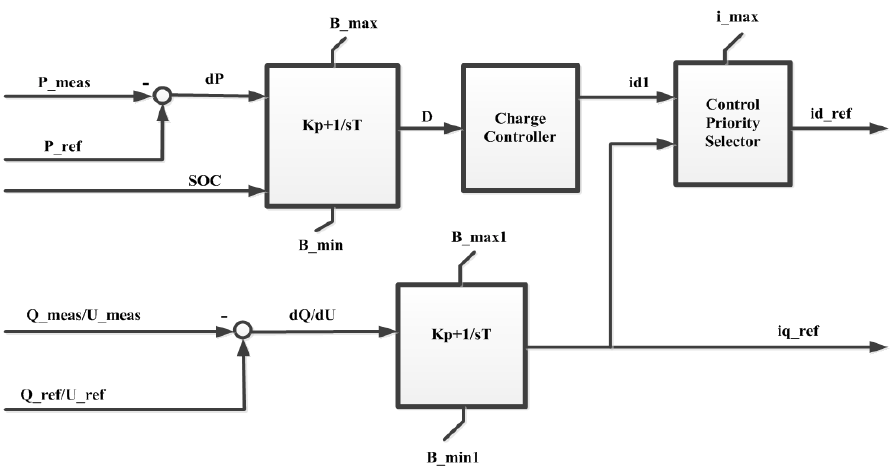
Figure 2. PQ/PV controller of BESS1 system in the grid connected mode.